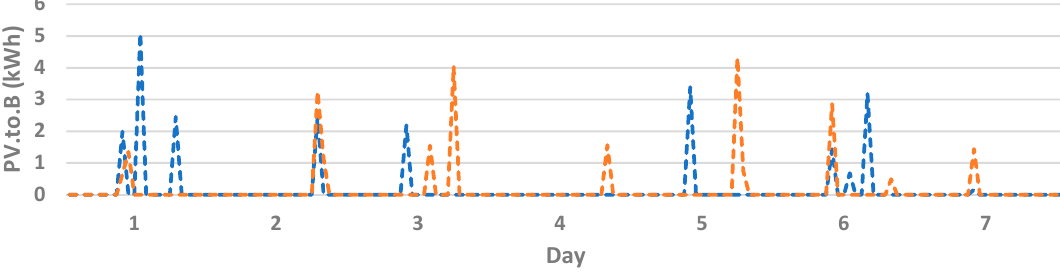
Figure 9. Energy transmission from PV panels to the battery bank, for a single dwelling. Comparison between the most and least probable scenarios (blue and orange) for one week of April. Source: self-elaboration.